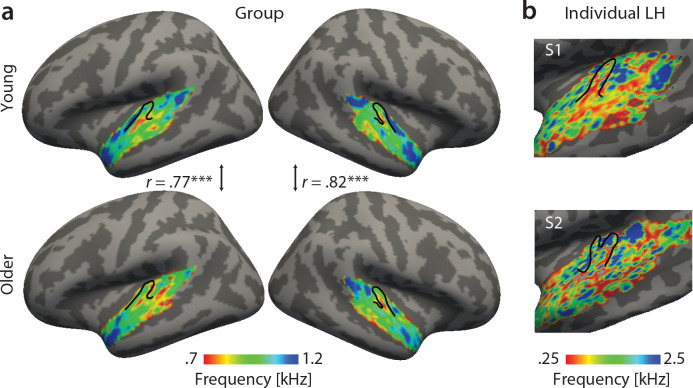
Tonotopic maps. Best frequency maps were derived by marginalizing modulation transfer functions (MTFs) for frequency and assigning the feature with the maximal response to a given voxel.(a) Group maps were obtained as median across subjects and are shown on FreeSurfer’s fsaverage5 template. Tonotopic maps in the young (upper panel) and older group (bottom panel) are correlated in both the right and left hemisphere. (b) Exemplary individual tonotopic maps for the left hemisphere (LH) of a young (upper panel) and older participant (bottom panel) are displayed on individual surfaces. Black outlines indicate Heschl’s gyrus. ***p<0.005.